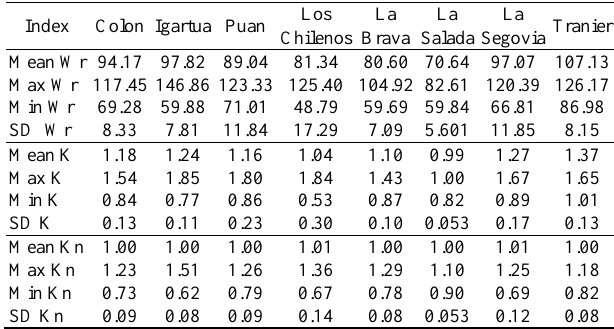
Table 3. Statistical parameters of K, Kn and Wr indices in sampled lakes. SD: standard deviation.